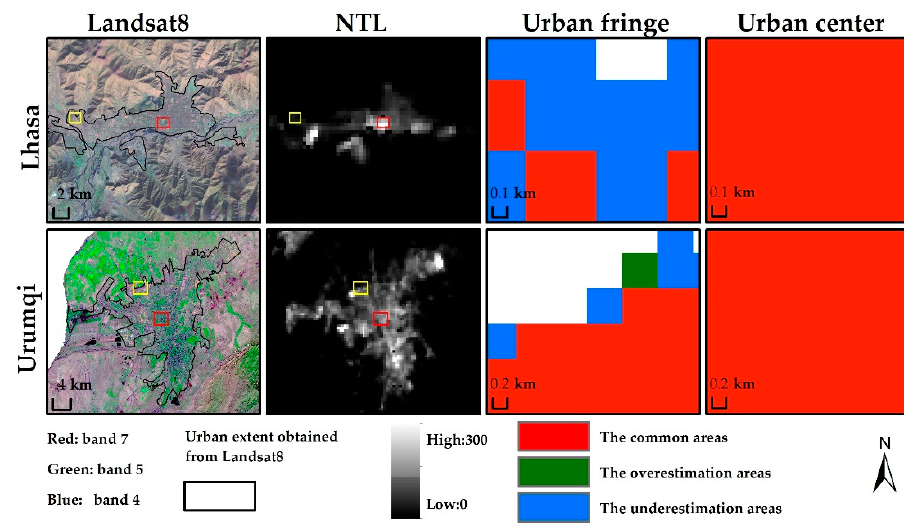
Figure 12. The spatial distribution of nighttime light intensity in Lhasa and Urumqi (yellow and red boxes indicate areas zoomed in column 3 and 4, respectively).